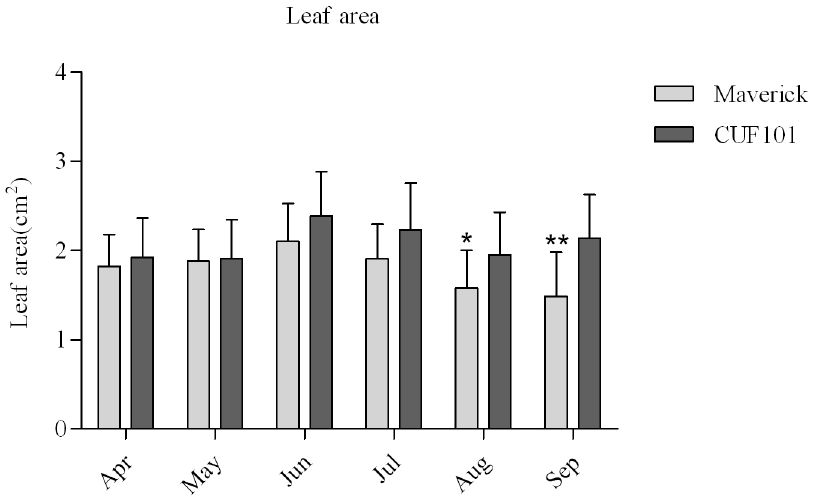
Fig 4. Leaf area of Maverickand CUF101 varietiesfrom April to October. * and ** indicate significant difference at p < 0.05 and p < 0.01, respectively.